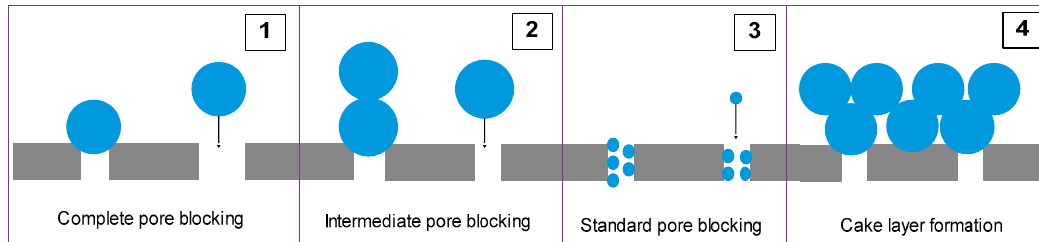
Figure 4. Schematic diagram of the four types of membrane fouling proposed by Hermia (Adapted from [23]).